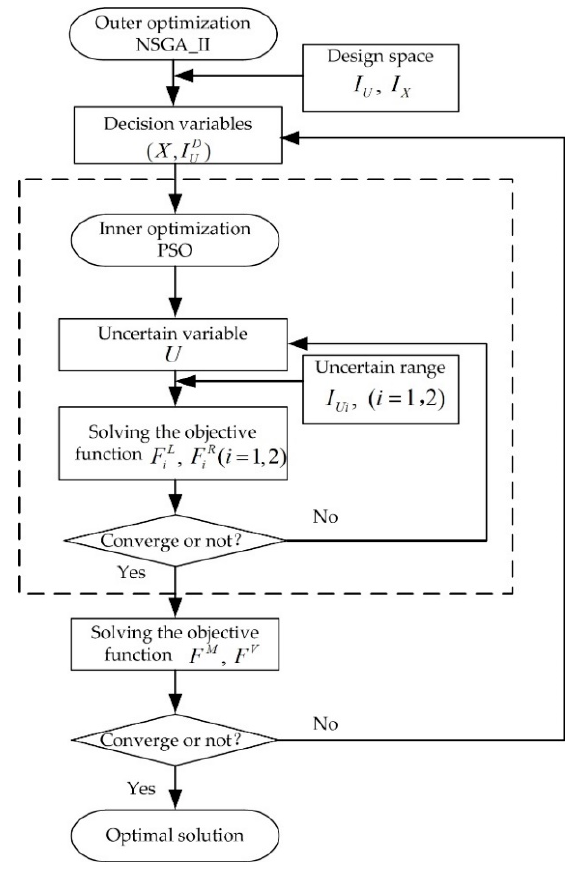
Figure 5. Bi-level nested optimization process.